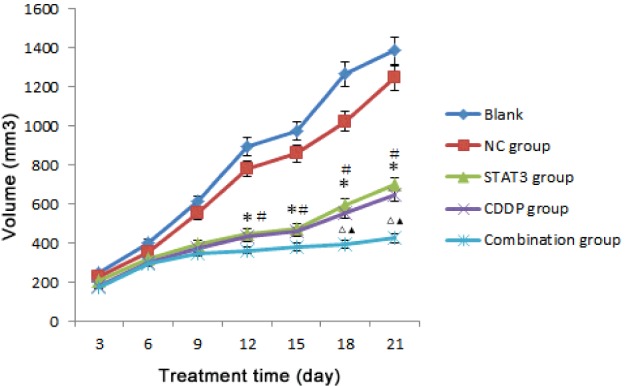
Tumour volume after different treatment time in each group. Compared with the blank control group*P<0.05; compared with the NC group, #P<0.05; compared with CDDP group, △P<0.05; compared with STAT3 group, ▲P<0.05.